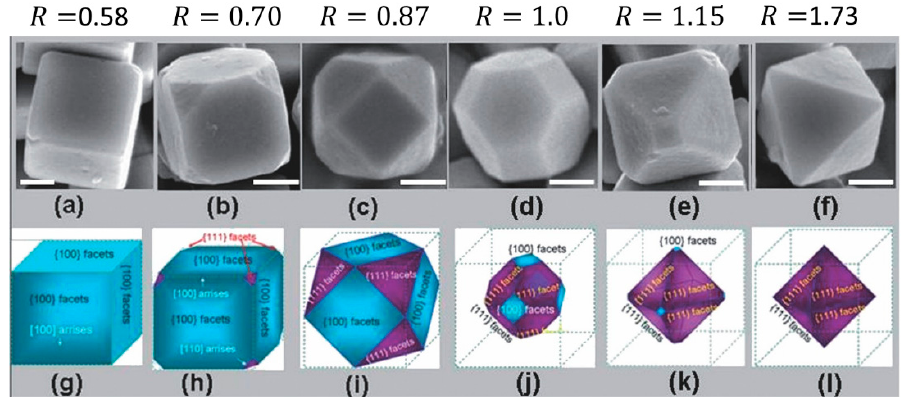
Figure 3. FESEM images of Cu 2 O polyhedrons with different volume ratio R of {100} to {111} where ( a ) R =0.58, ( b ) R =0.70, ( c ) R =0.87, ( d ) R =1.0, ( e ) R =1.15, ( f ) R =1.73 with corresponding geometry 3D models ( g-l ). Reprinted with permission from ref. [156].